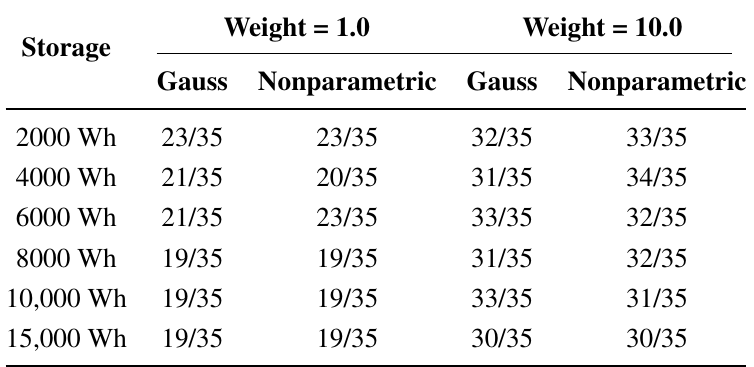
Table 1. Fraction of the 35 households in which the null hypothesis was rejected. Weight = Storage